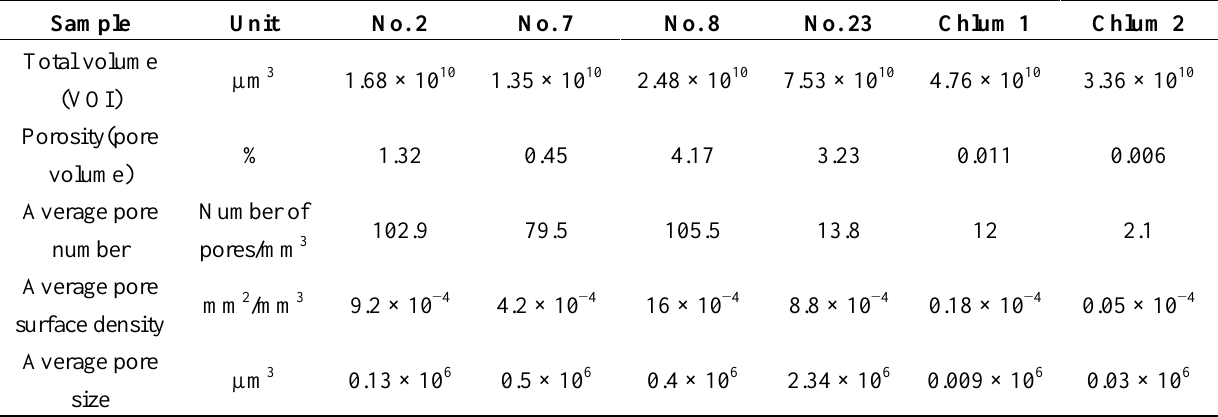
Table 1. Porosity analysis results of six